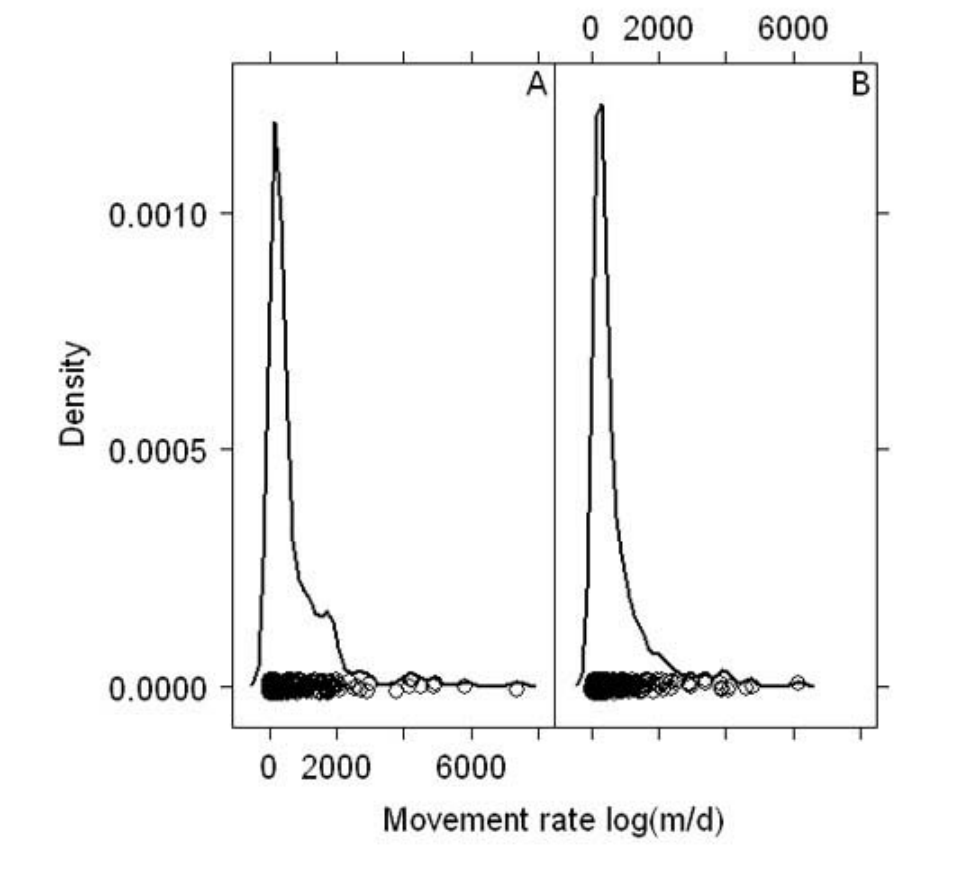
Fig. 4. Density and rug plots illustrating movement rate distributions for (A) Blackpoll and (B) Yellow- rumped Warblers. Density represents the relative proportion of observations for a given movement